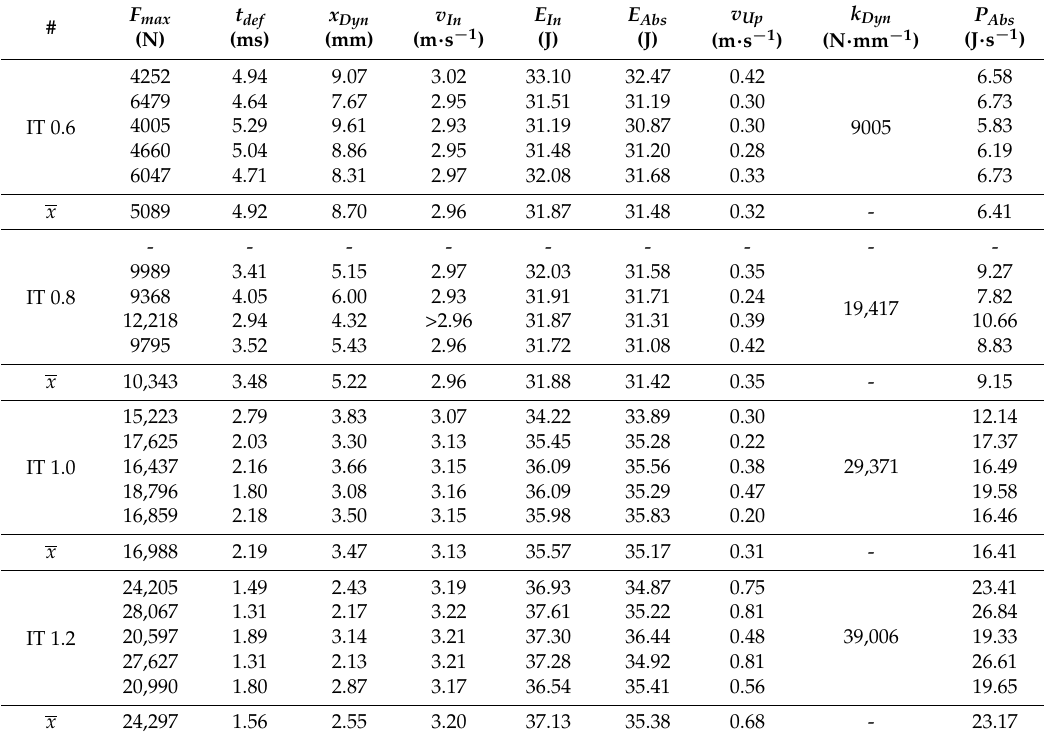
Table 6. The results of the low-velocity impact.